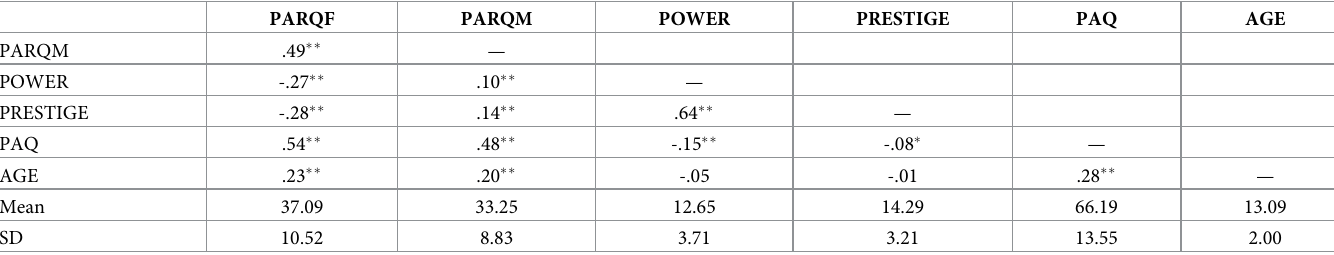
Table 1. Correlations between parental acceptance-rejection, power, prestige and child